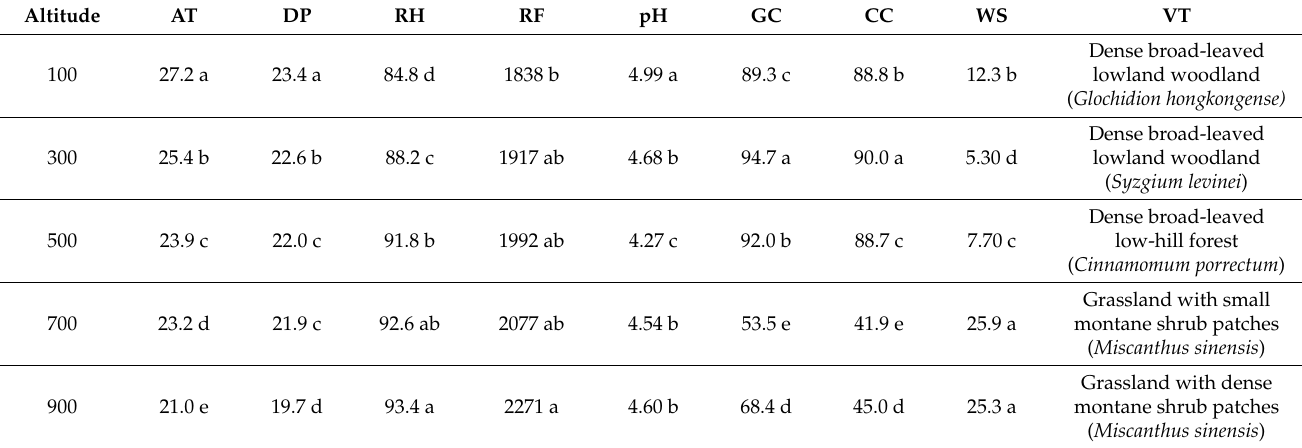
Values followed by different letters are significantly different ( p < 0.05) among various altitudes. Altitude: m above sea level; AT: ◦ C mean daily air temperature; DP: ◦ C dew point; RH: % relative humidity; RF: mm rainfall; GC: % ground cover; CC: % canopy closure; WS: wind speed km/h; VT: vegetation type (with most dominant species for each elevation within